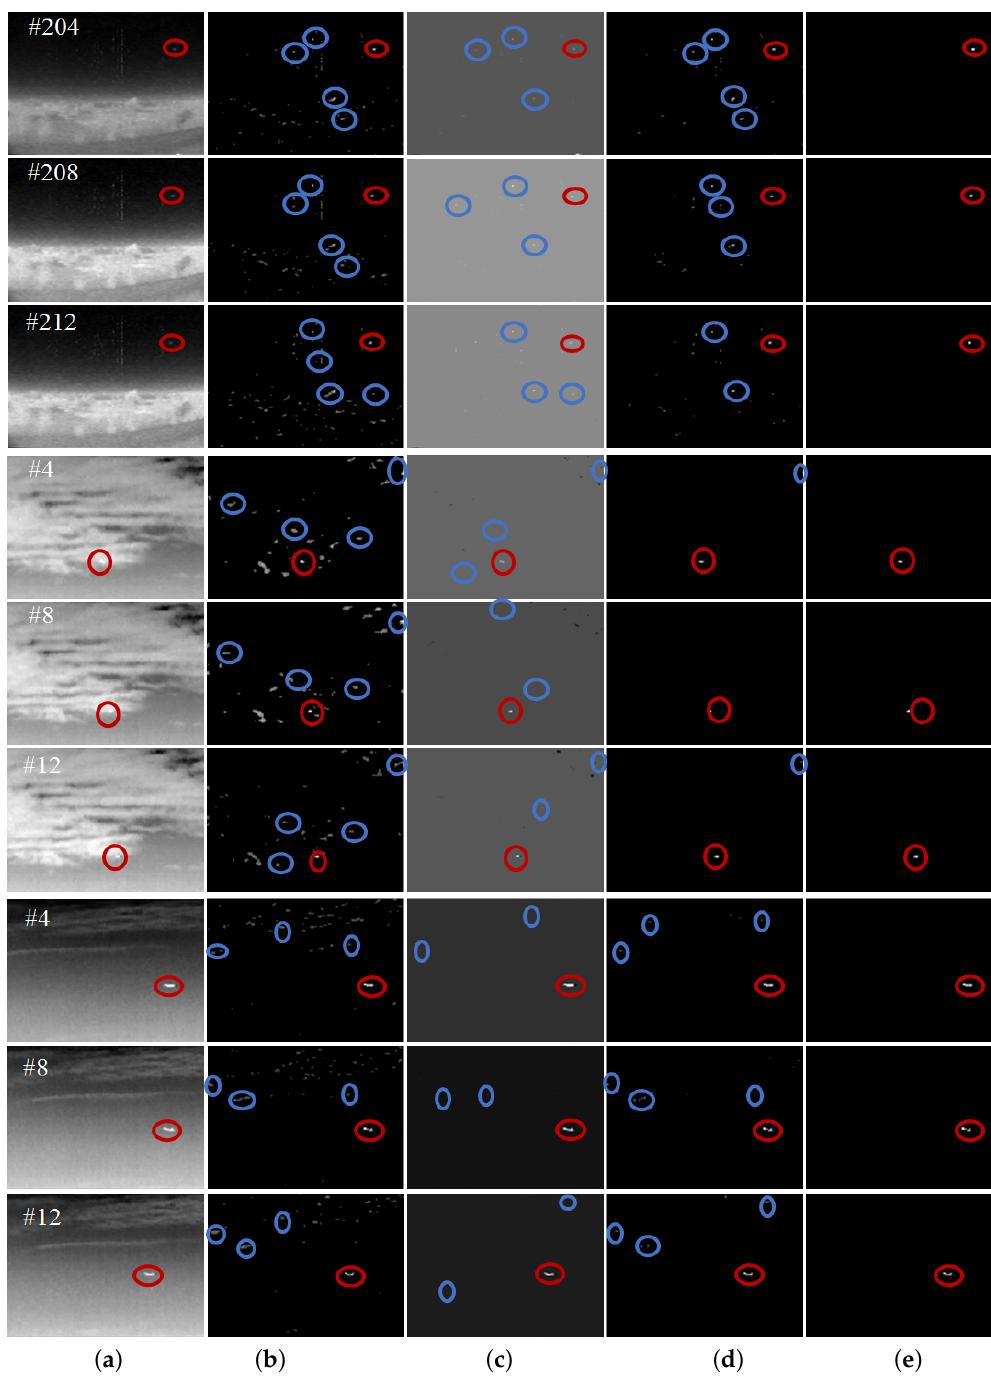
Figure 2. Visual illustration of the procedures of the proposed method. The first three rows, the middle three rows, and the last three rows illustrate the results of the proposed method on Sequence 1, Sequences 2 and Sequence 3 respectively. ( a ) denotes the original images selected from three sequences, ( b ) denotes the dense reconstruction map D d , ( c ) denotes the sparse reconstruction map D s k the location correlation map D c of D d and D s , and ( e ) denotes the refined map D r k k k